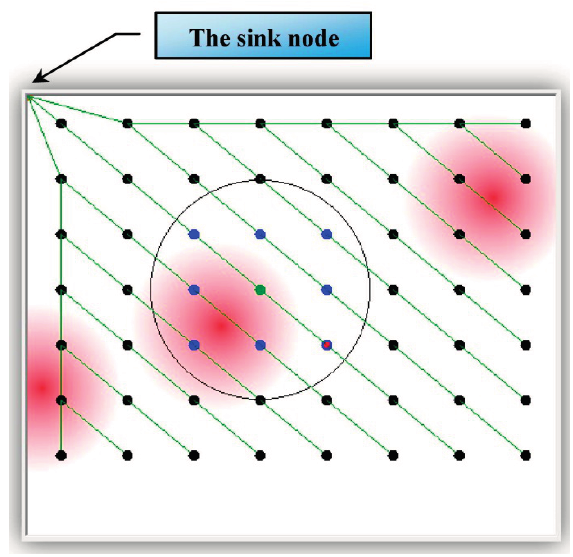
Figure 4. The monitored field with grid-deployed nodes.